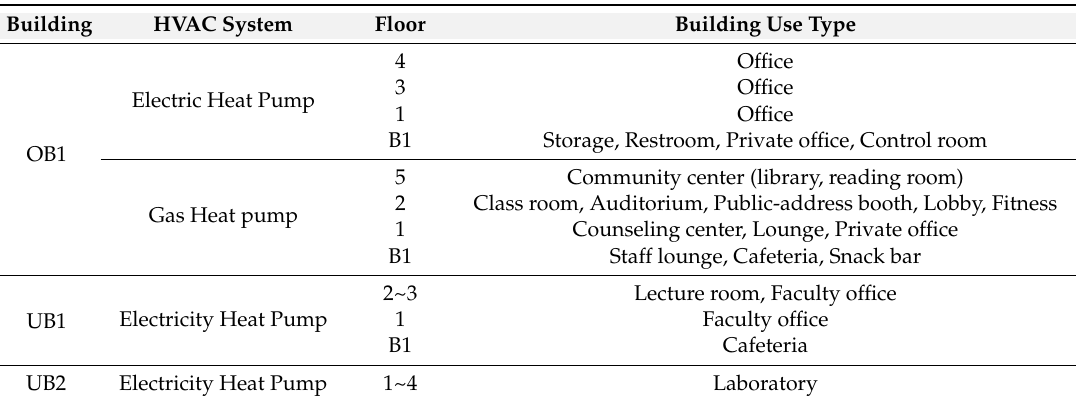
Table 5. HVAC system of the buildings studied.